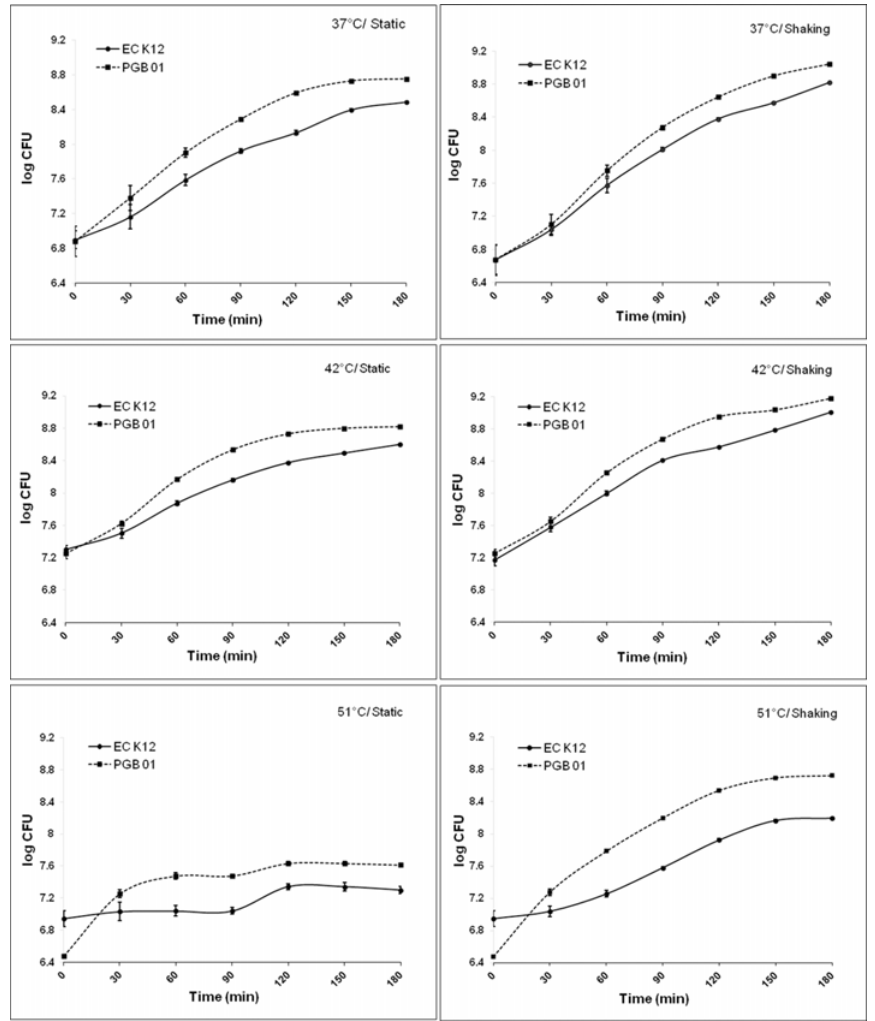
Fig 1. Growth curve at different temperatures. Growth curve of ECK12 and PGB01 in static and shaking condition at 37 ° C, 42 ° C and 51 ° C.